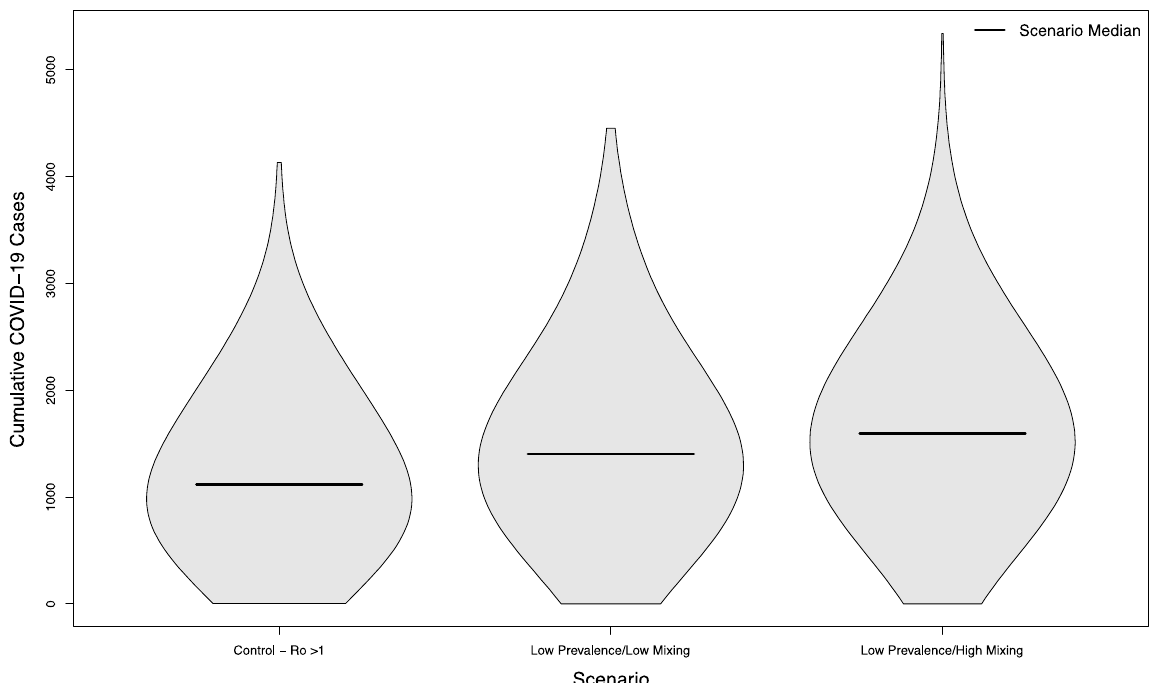
Figure 5. Distribution of cumulative COVID-19 cases in 1000 simulated university campuses with uncontrolled epidemics, comparing a campus with no in-person sporting events to two scenarios where visitors come from a low prevalence area and mix with the campus community at a low rate or a high rate,